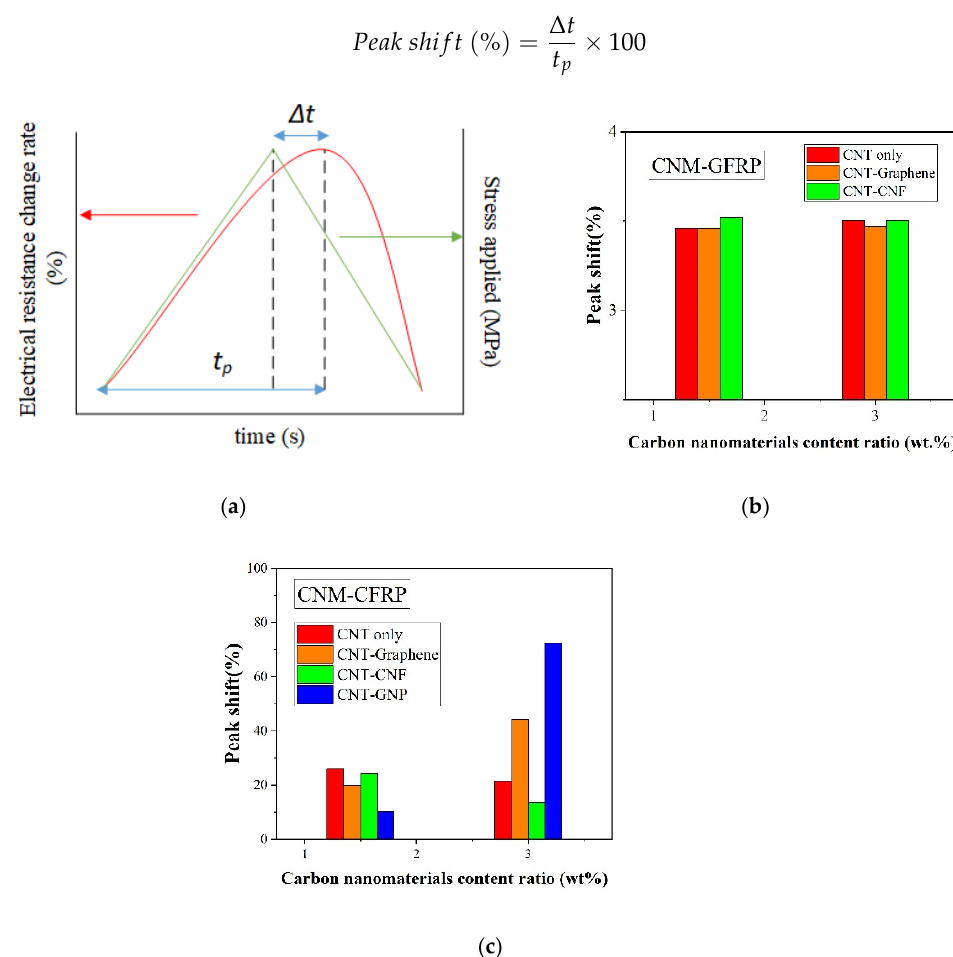
Figure 11. ( a ) Illustrative descriptions of the peak shift cf. [50], ( b ) calculated peak shift values of the CNM-incorporated GFRP composites, and ( c ) calculated peak shift values of the CNM-incorporated CFRP composites. Peak shift represents the electrical resistance changes in the composites with respect